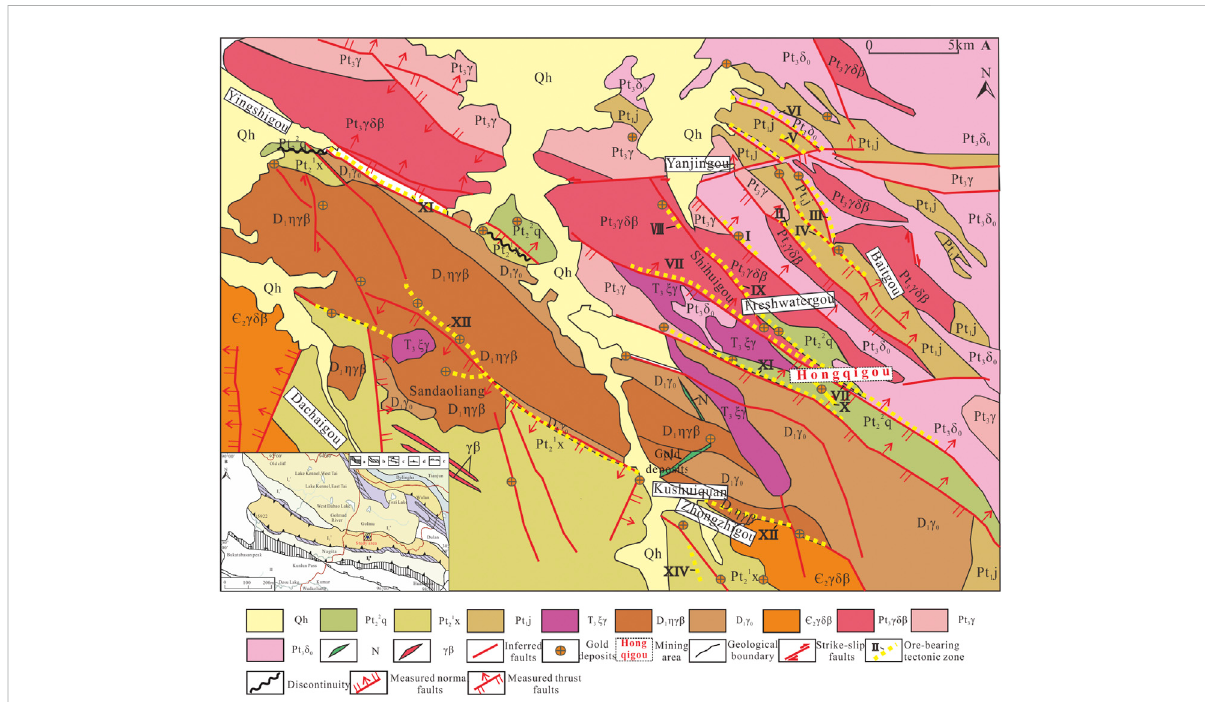
FIGURE 1 (a) Geological sketch of the Wulonggou gold deposit (Zhang et al., 2011). Abbreviations are as follows: Qh, Quaternary alluvial and diluvial sediments;